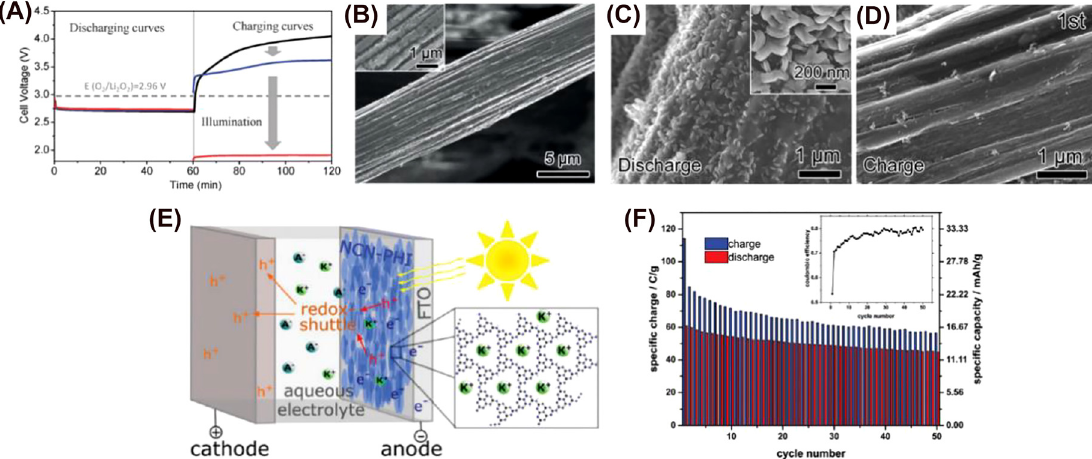
Figure 11: Carbon nitride-based photoelectrodes. (A) Charging – discharging curves of g-C 3 N 4 -based Li – O 2 battery with (blue line), without (black line) the I - ion redox mediator; and